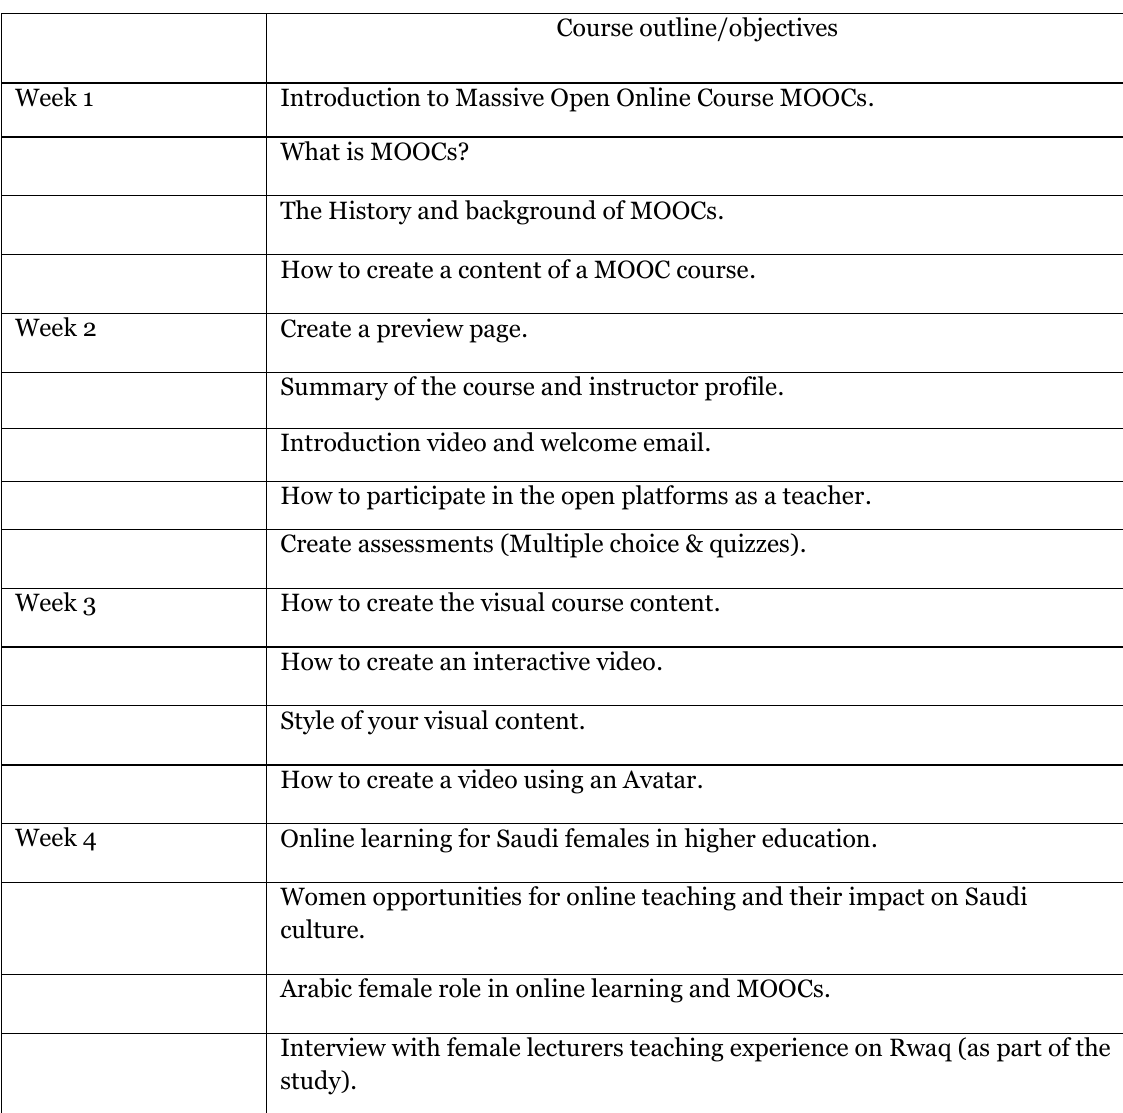
Table 2 The Rwaq Course Outline